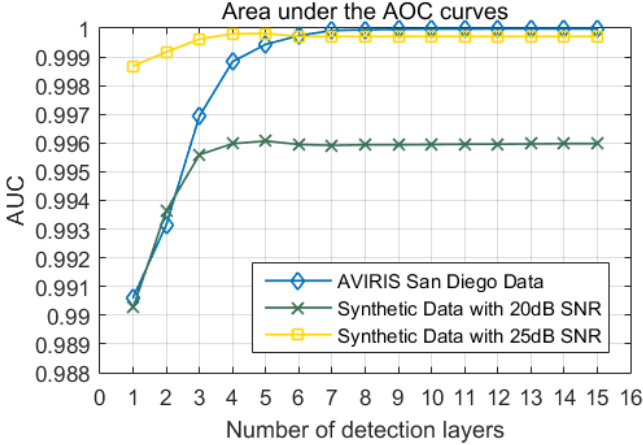
Figure 11. The area under the ROC of the proposed E-CEM detector’s detection results under its 1st ∼ 15th detection layers on the Synthetic data and the AVIRIS San Diego data.